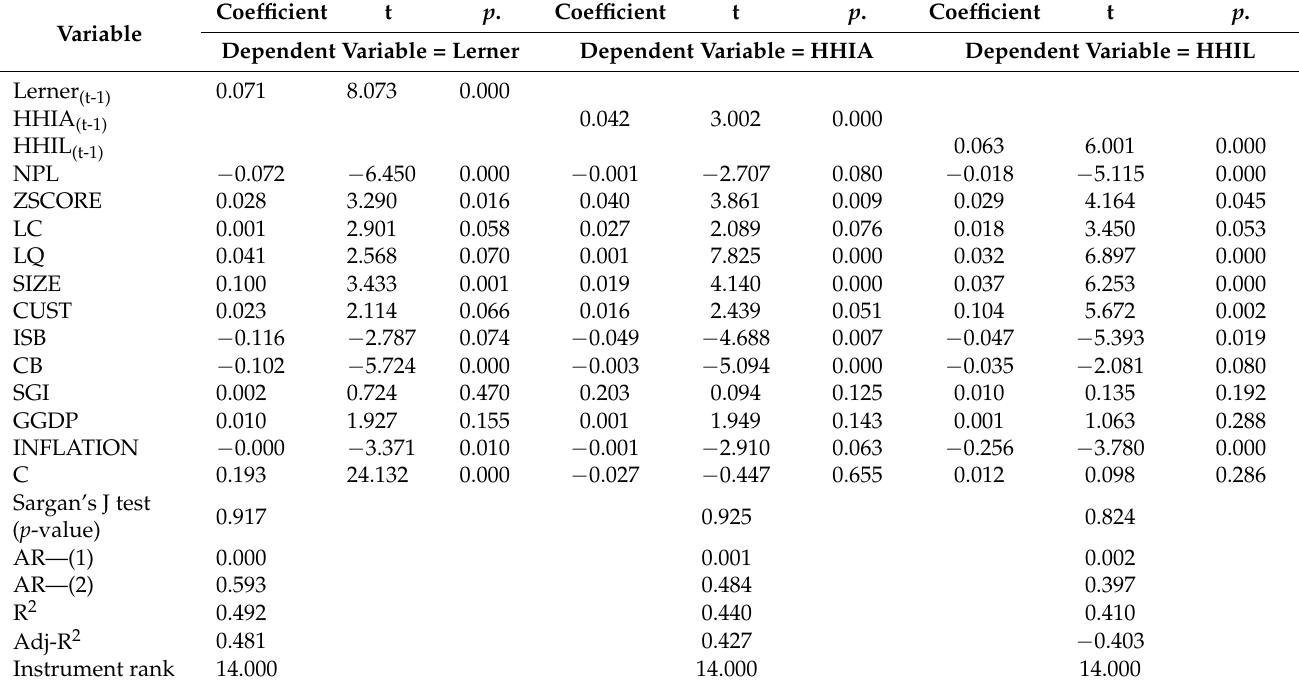
Table 11. Bidirectional causality of competition and risk concerning the impact of ownership